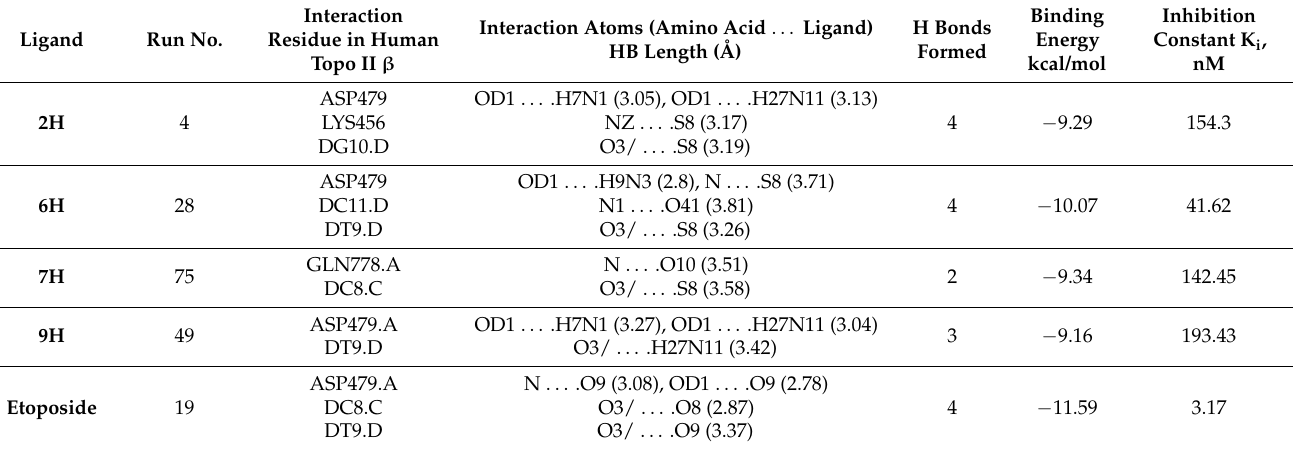
Table 5. Computed molecular interactions of the four derivatives of TUDHIPP ( 2H , 6H , 7H , and 9H ) with human DNA topoisomerase II β